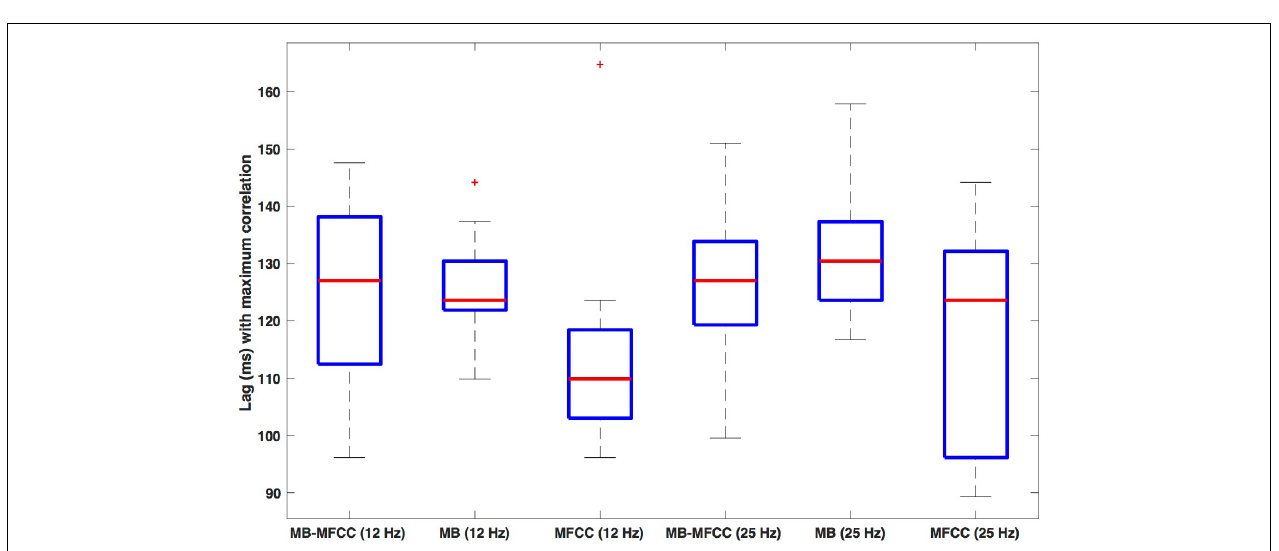
FIGURE 7 | Sample results of CMA lag analysis for one speaker for correlation between MBEAM and MFCC modulation functions filtered at 12 Hz with η = 0.8. (Top) Shows the median value of the correlation function for each signal lag in ms. Vertical lines indicate correlation minima and secondary maxima. (Bottom) Shows the percentage of correlation values that are positive at each lag.